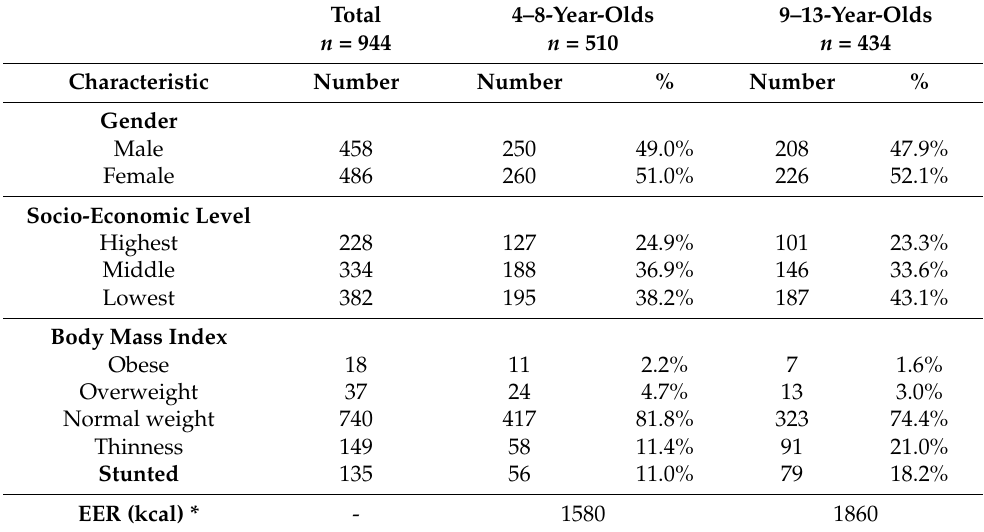
Table 1. Ibadan Kids Nutrition and Health Study: sample population characteristics and estimated energy